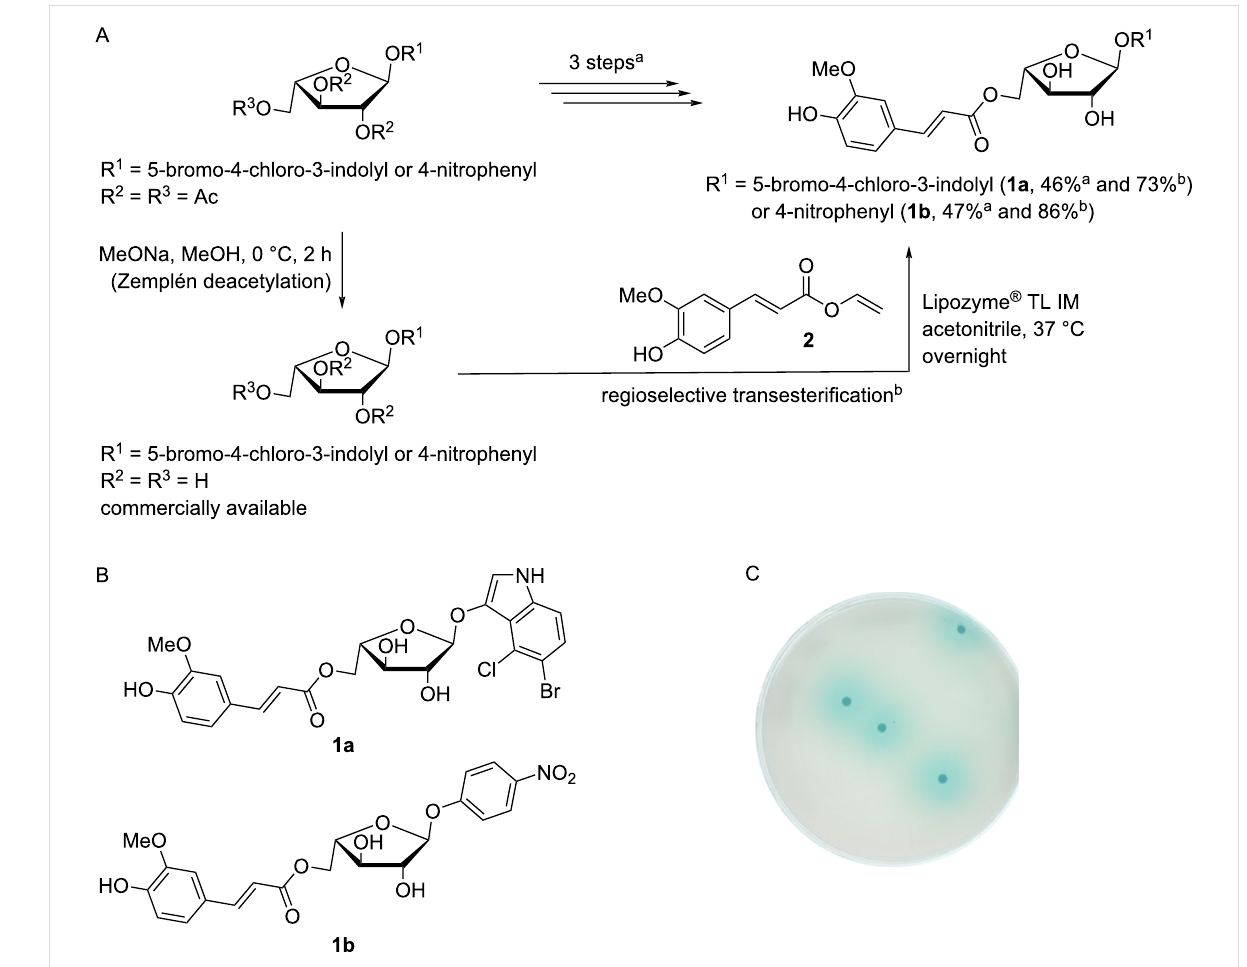
Figure 1: Alternative syntheses (A) and full structures (B) of the 5-bromo-4-chloro-3-indolyl or 4-nitrophenyl 5- O -feruloyl- α - ʟ -arabinofuranosidic chromogenic substrates 1a and 1b and (C) detection of type A Fae activity on solid agar medium using 1a . The overall yield of the transesterifications of 1a and 1b are reported for both pathways. a 3-step pathway. b 1-step